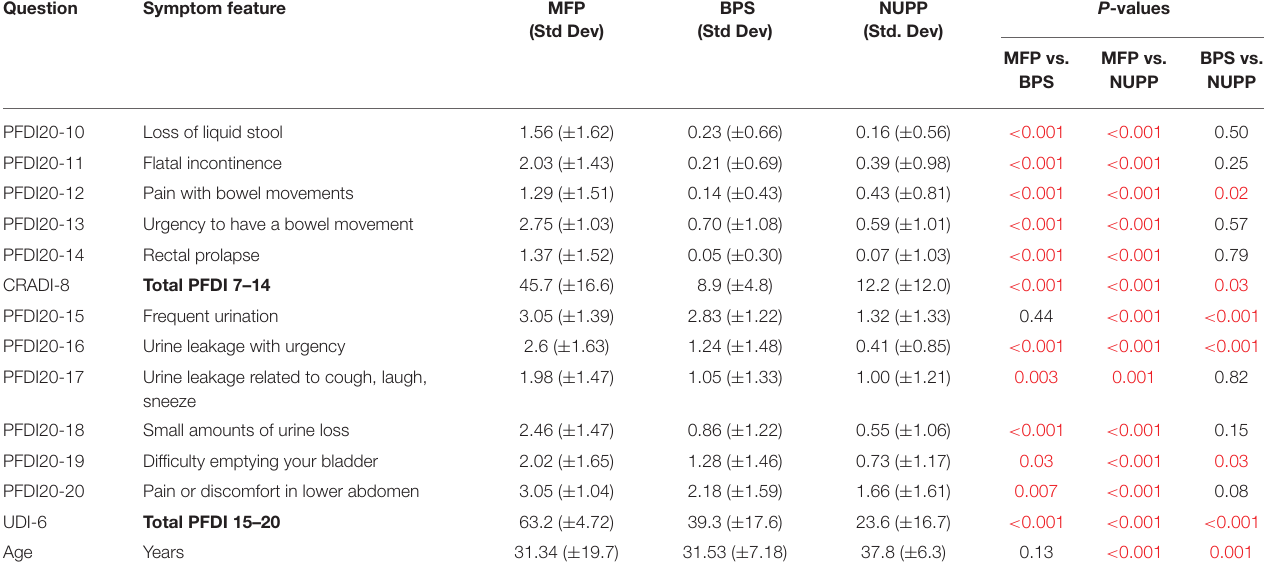
fGUPI1A-2Dareyes/noquestions;theresponsesareshownasproportions.AllotherquestionsareLikertscales,forwhichthemeansandstandarddeviationsareshown.ICSI,Interstitial Cystitis Symptom Index; ICPI, Interstitial Cystitis Problem Index; OLS, O’Leary-Sant Indices total score; OABqSF, Overactive Bladder Questionnaire Short Form; fGUPI, Genitourinary Pain Index; PFDI-20, Pelvic Floor Distress Inventory Short Form; POPDI-6, Pelvic Organ Prolapse Distress Inventory 6; CRADI-8, Colorectal-Anal Distress Inventory 8; UDI-6,